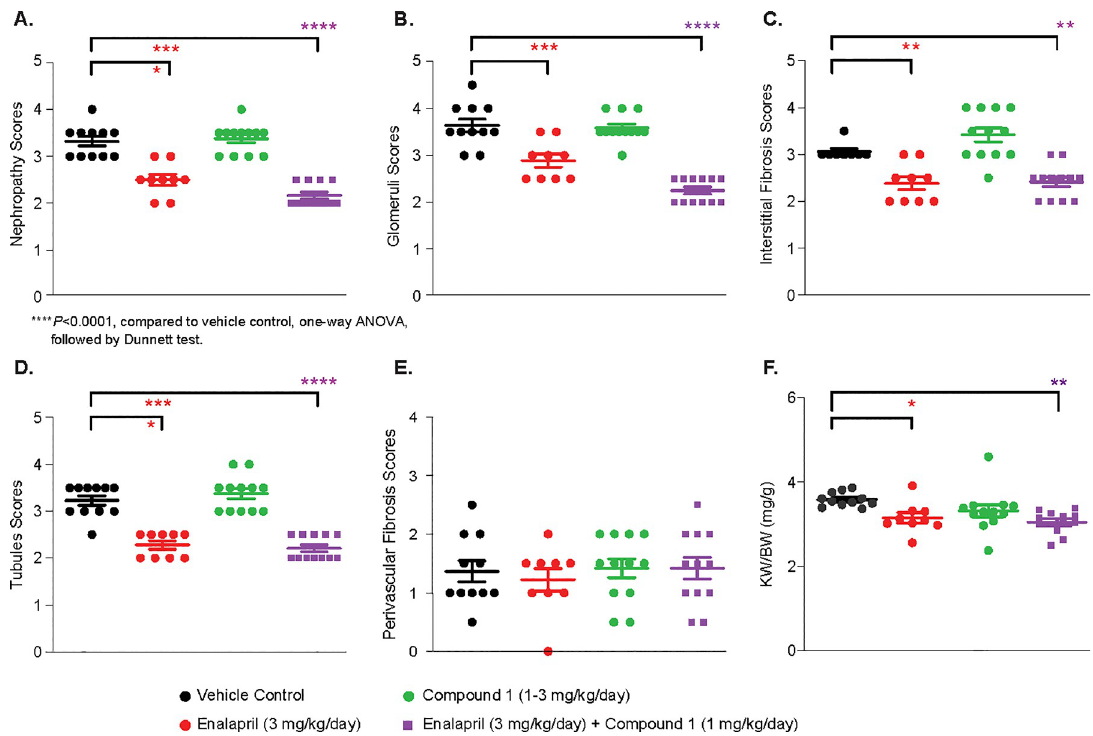
Fig 7. Renal histology after 6 months of Compound 1 administration. (A) Nephropathy score is a combined score from each component (tubules, interstitial, and glomeruli). Enalapril or combination significantly reduced nephropathy score as well as tubular injury (D) vascular interstitial (E) and glomerular injury scores (B), while Compound 1 did not have an effect. (F) Kidney weight to body weight ratio was significantly reduced by Enalapril or combination treatment.